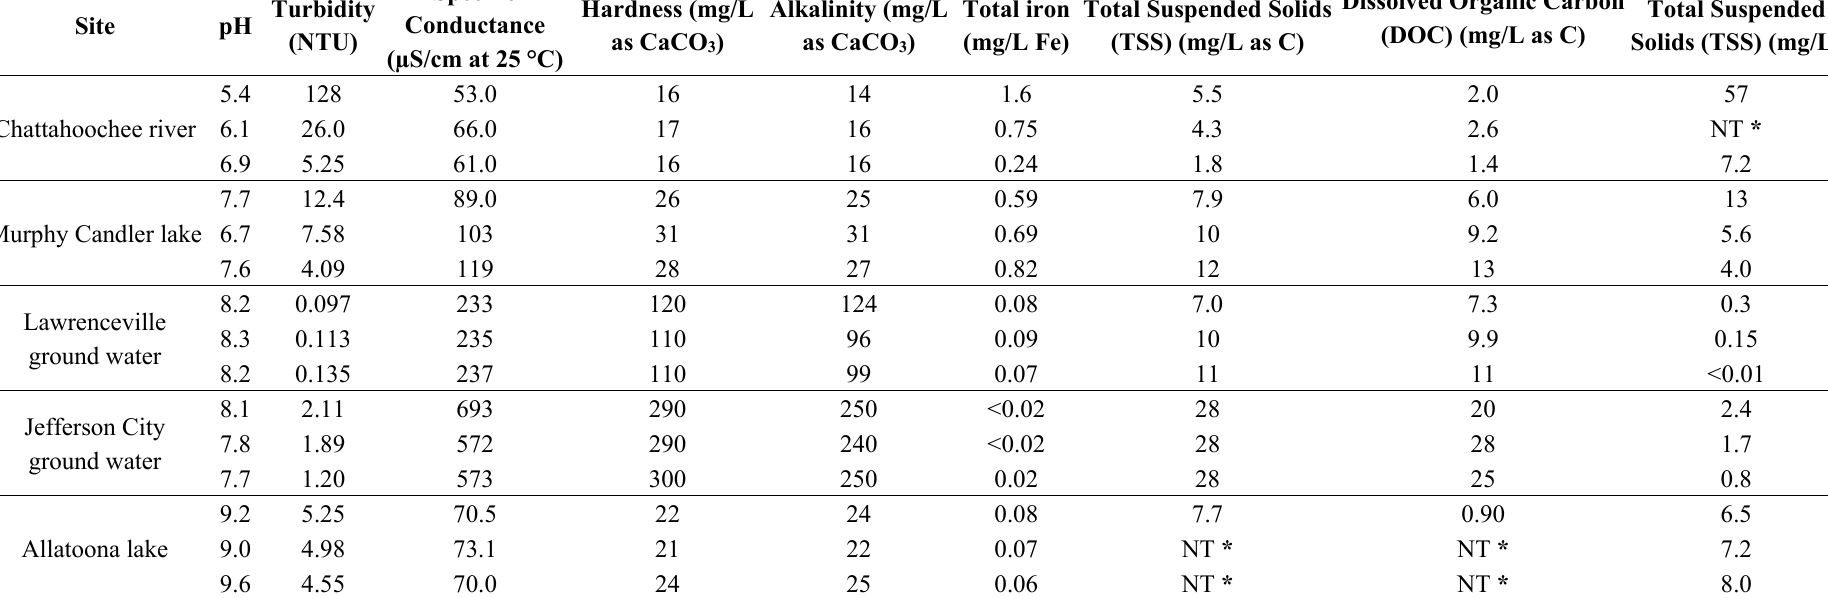
Table 1. Water quality data for environmental water samples.